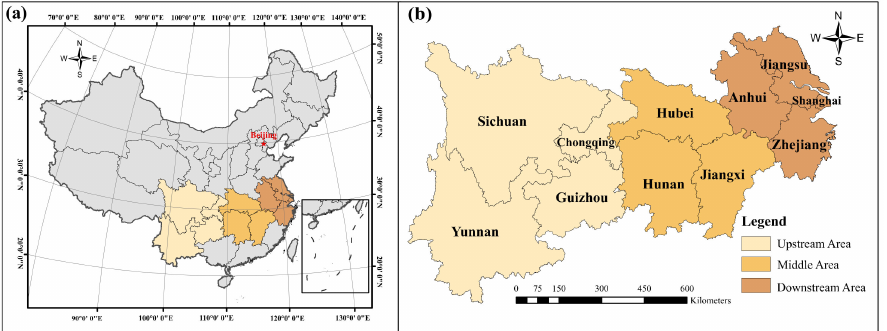
Figure 1. ( a ) Map of the geographical location of the YREB in China; ( b ) map of the upstream, midstream, and downstream distribution of the YREB. Source: Authors’ drawing using ArcGIS10.7